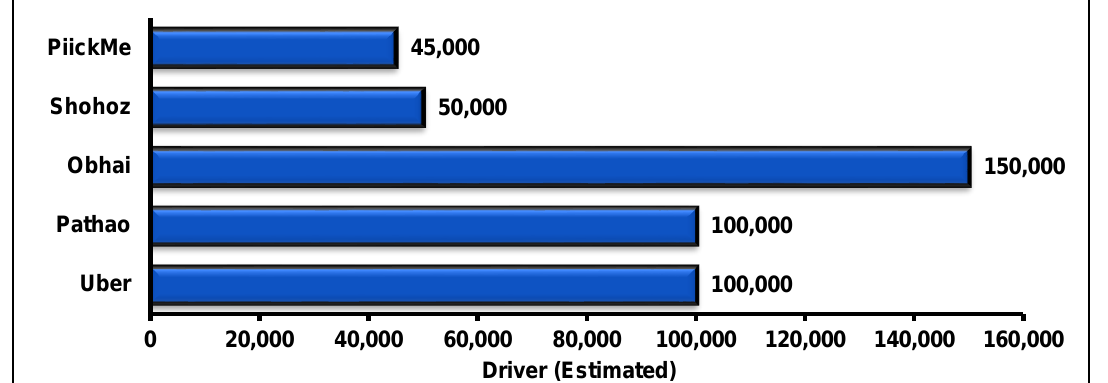
Fig. 5. Driver compliance in Bangladesh for each ride-sharing